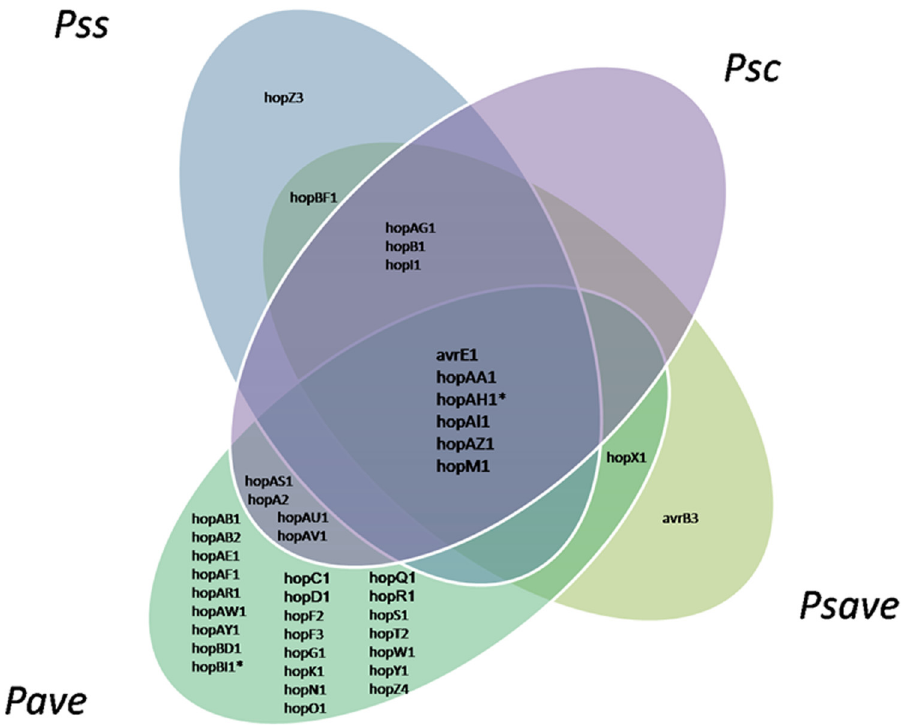
Fig 5. Venn diagram of the type III secretion system effector genes complement of nine pseudomonad strains infecting Corylus avellana trees. Pave: Pseudomonas avellanae ; Psave: P . syringae pv. avellanae ; Psc: P . s . pv. coryli ; Pss: P . s . pv. syringae . * : not present in P . avellanae BPIC 631.